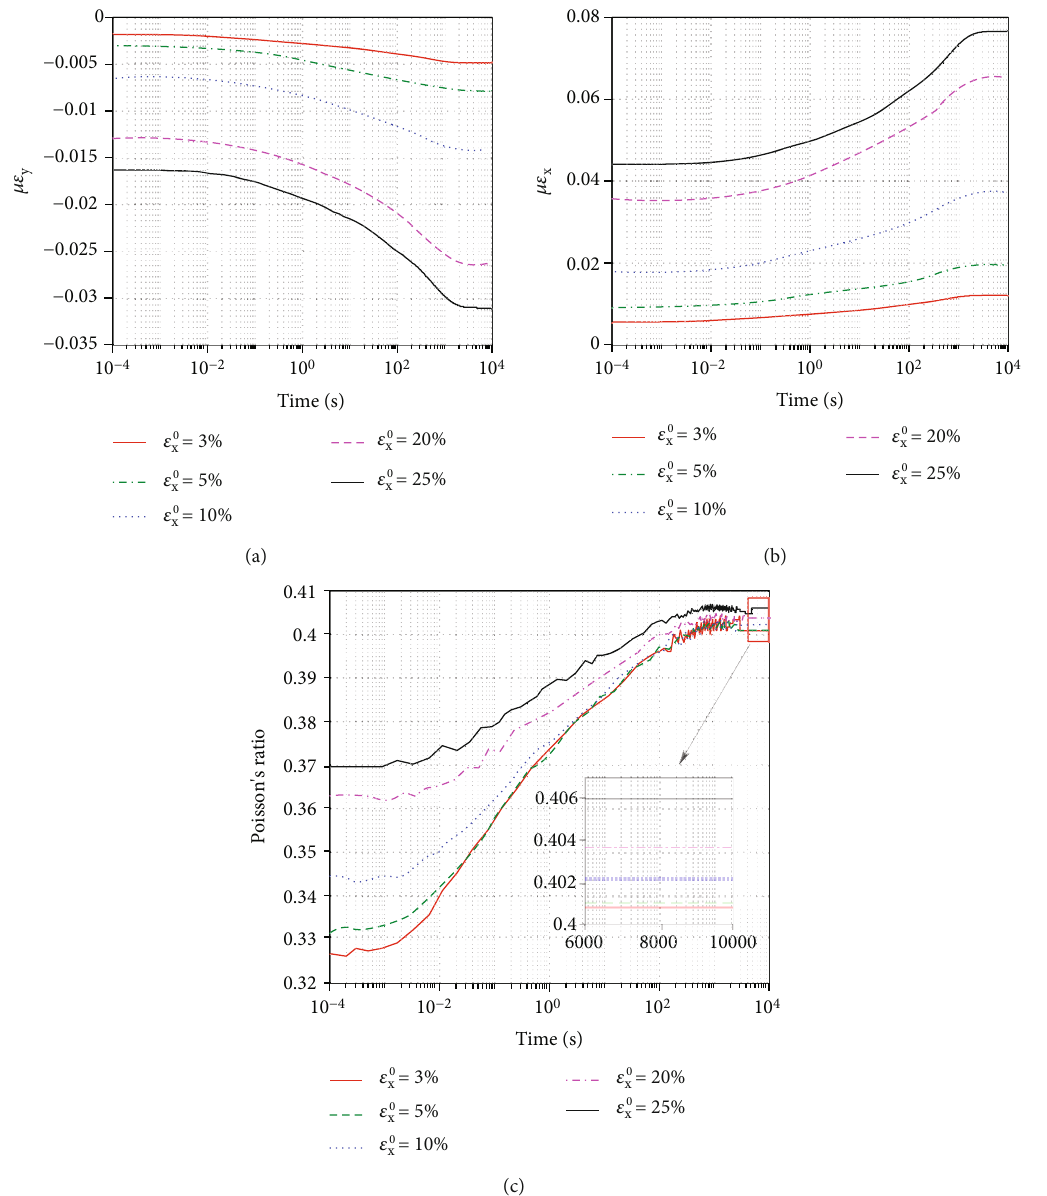
Figure 12: The curves of the (a) longitudinal strain, (b) transverse strain, and (c) Poisson ’ s ratio versus time under di ff erent fi xed strains when cohesive strength equals to